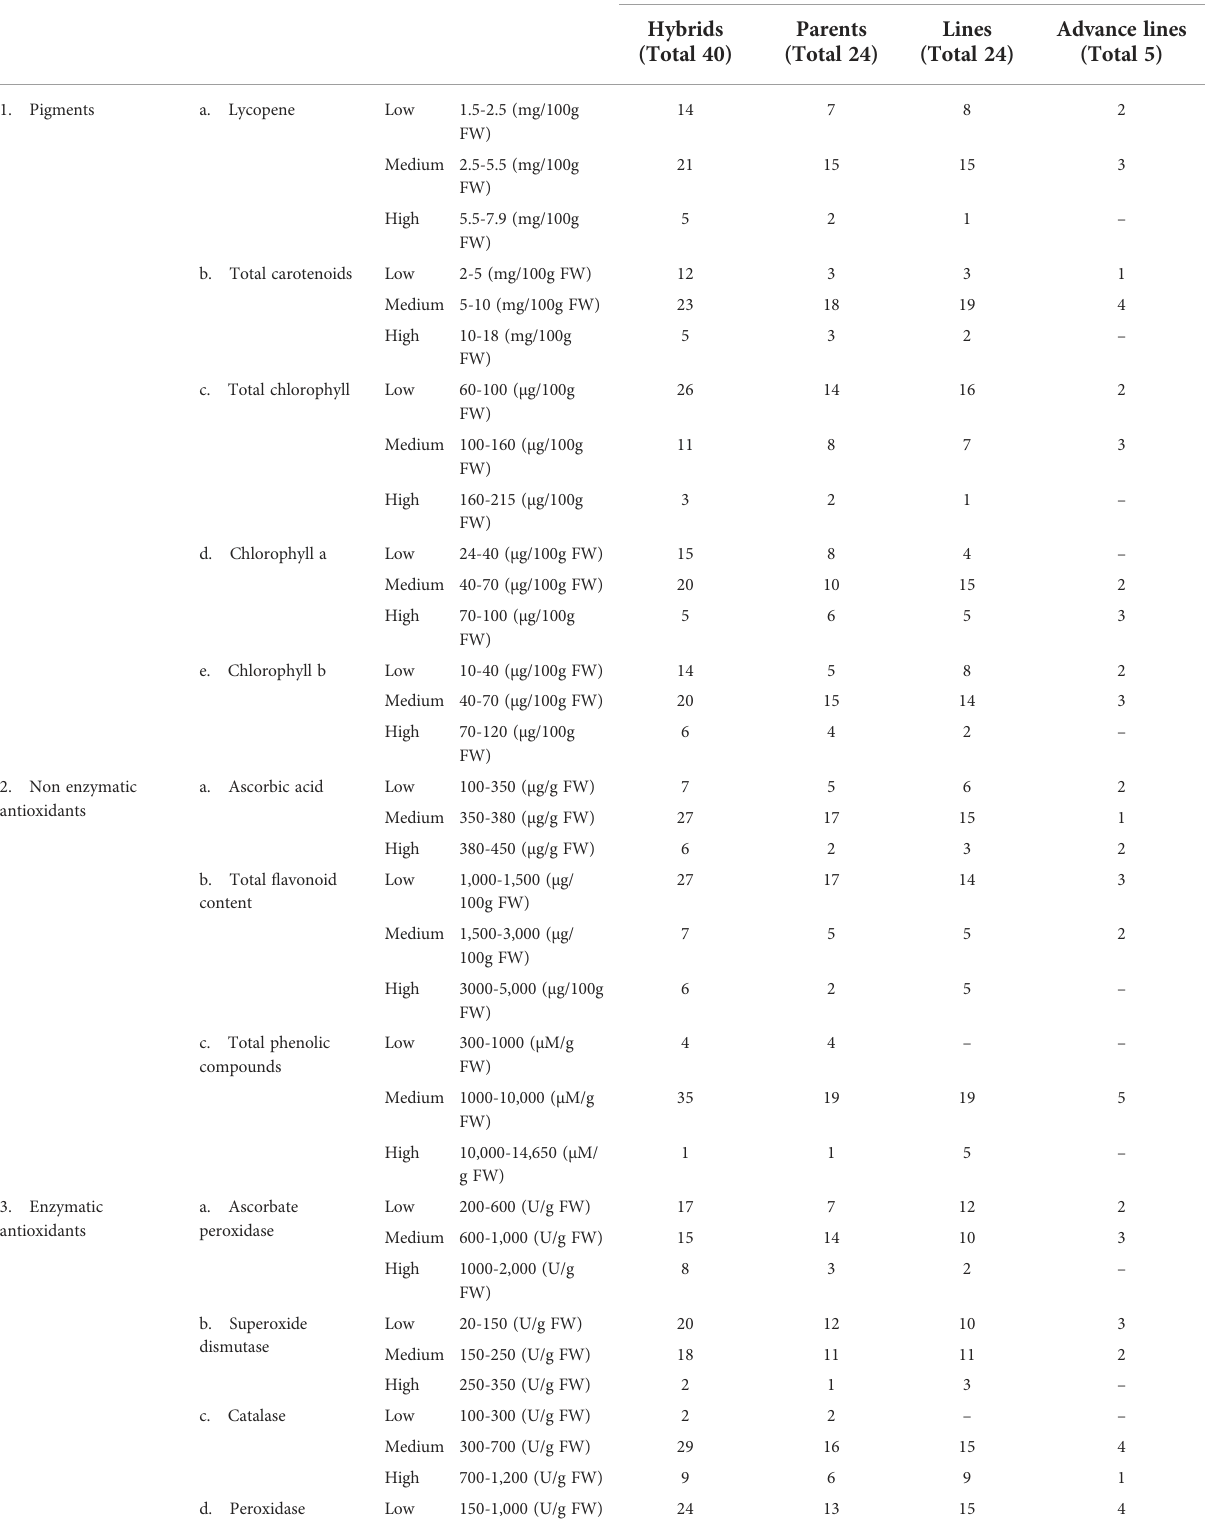
TABLE 2 Scale for categorization of tomato genotypes having low, medium, and high values of different biochemical parameters.